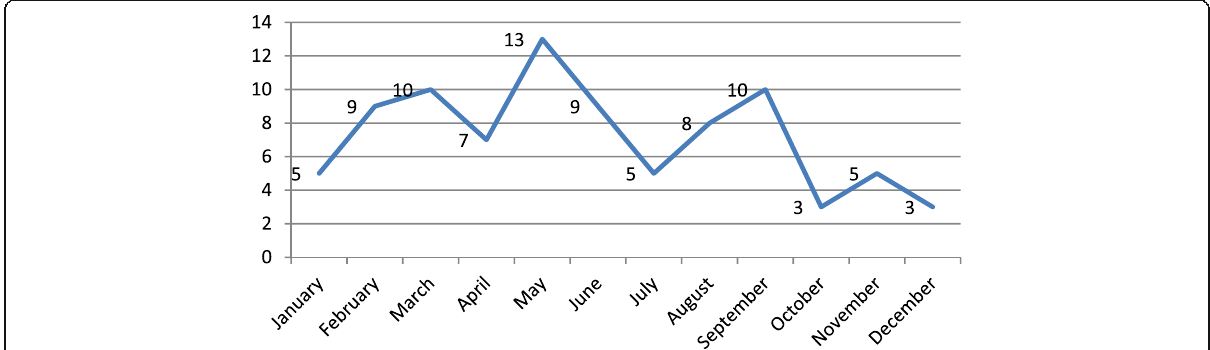
Fig. 3 Distribution of cases number according to the crime